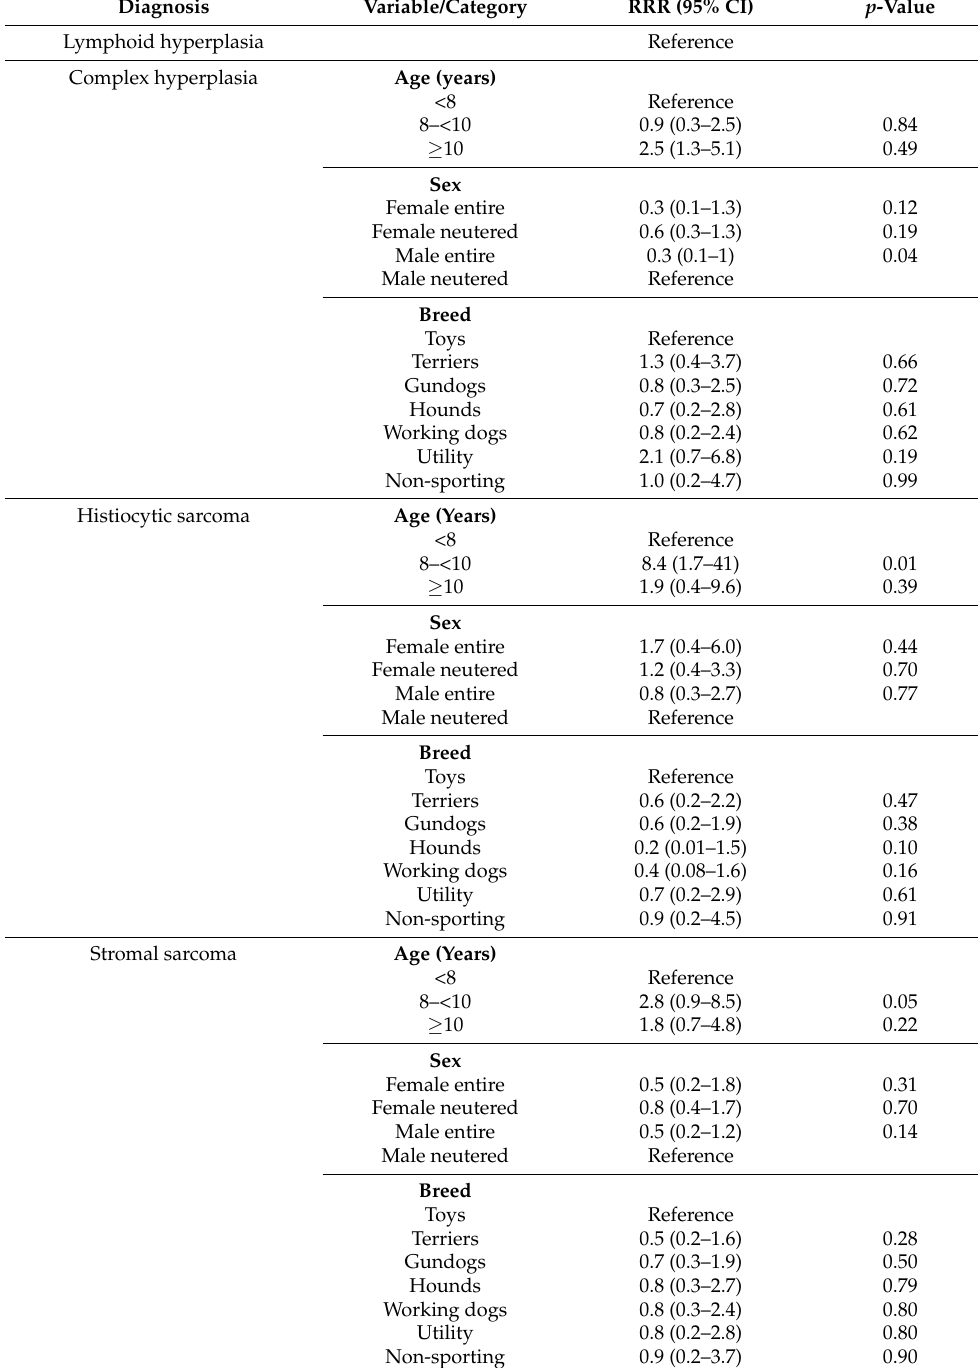
Table 4. Multinomial analysis of risk factors for diagnosis of the different types of splenic fibrohistio- cytic nodules in dogs identified from the VetCompass Australia database that attended primary-care veterinary clinics during 1989–2018 in